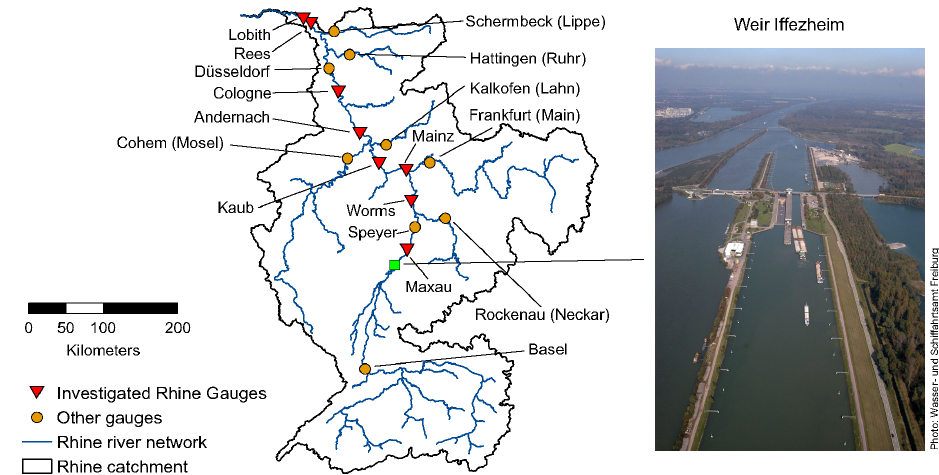
Fig. 1. Study area of the Rhine catchment with the river network and location of the major